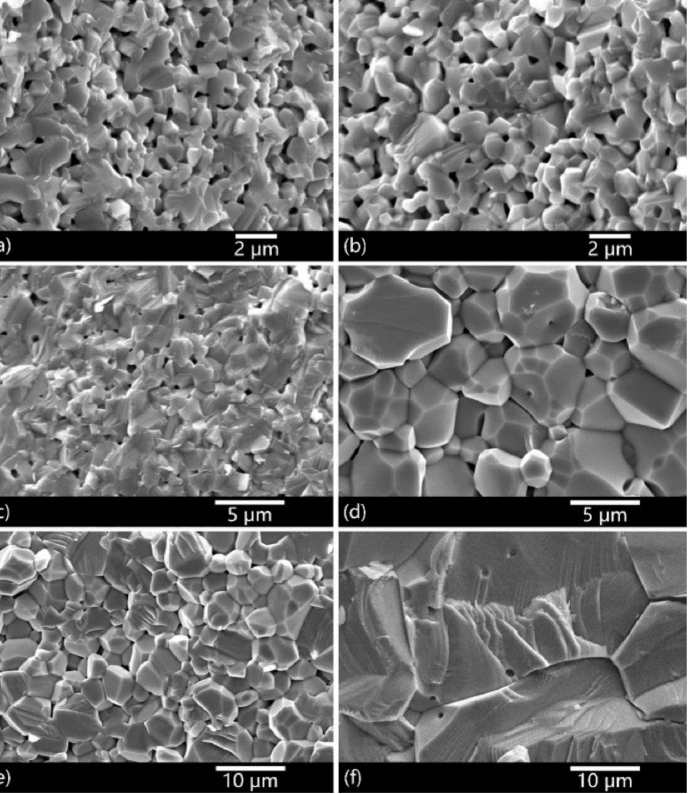
Figure 3. SEM images of 0.02 wt.% CaO-doped ( a , c , e ) and 0.15 wt.% CaO-doped samples ( b , d , f ), vacuum sintered at 1450 ◦ C, 1550 ◦ C and 1650 ◦ C,